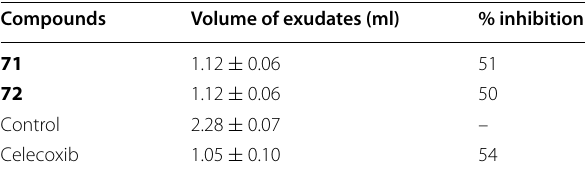
Table 23 Inflammation reduction results of synthesized compounds in turpentine oil induced granuloma pouch bioassay in rat